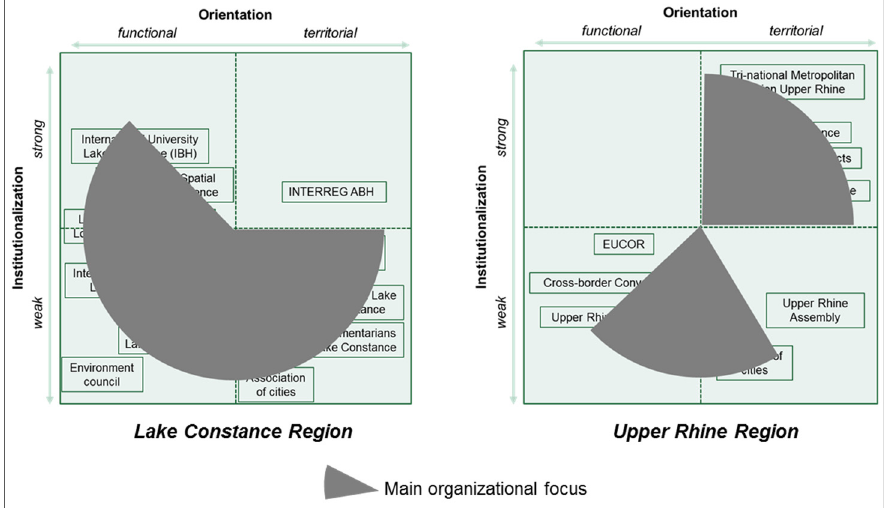
Figure 5. Comparison of cross-border organization in the case regions. Source: Authors’ own